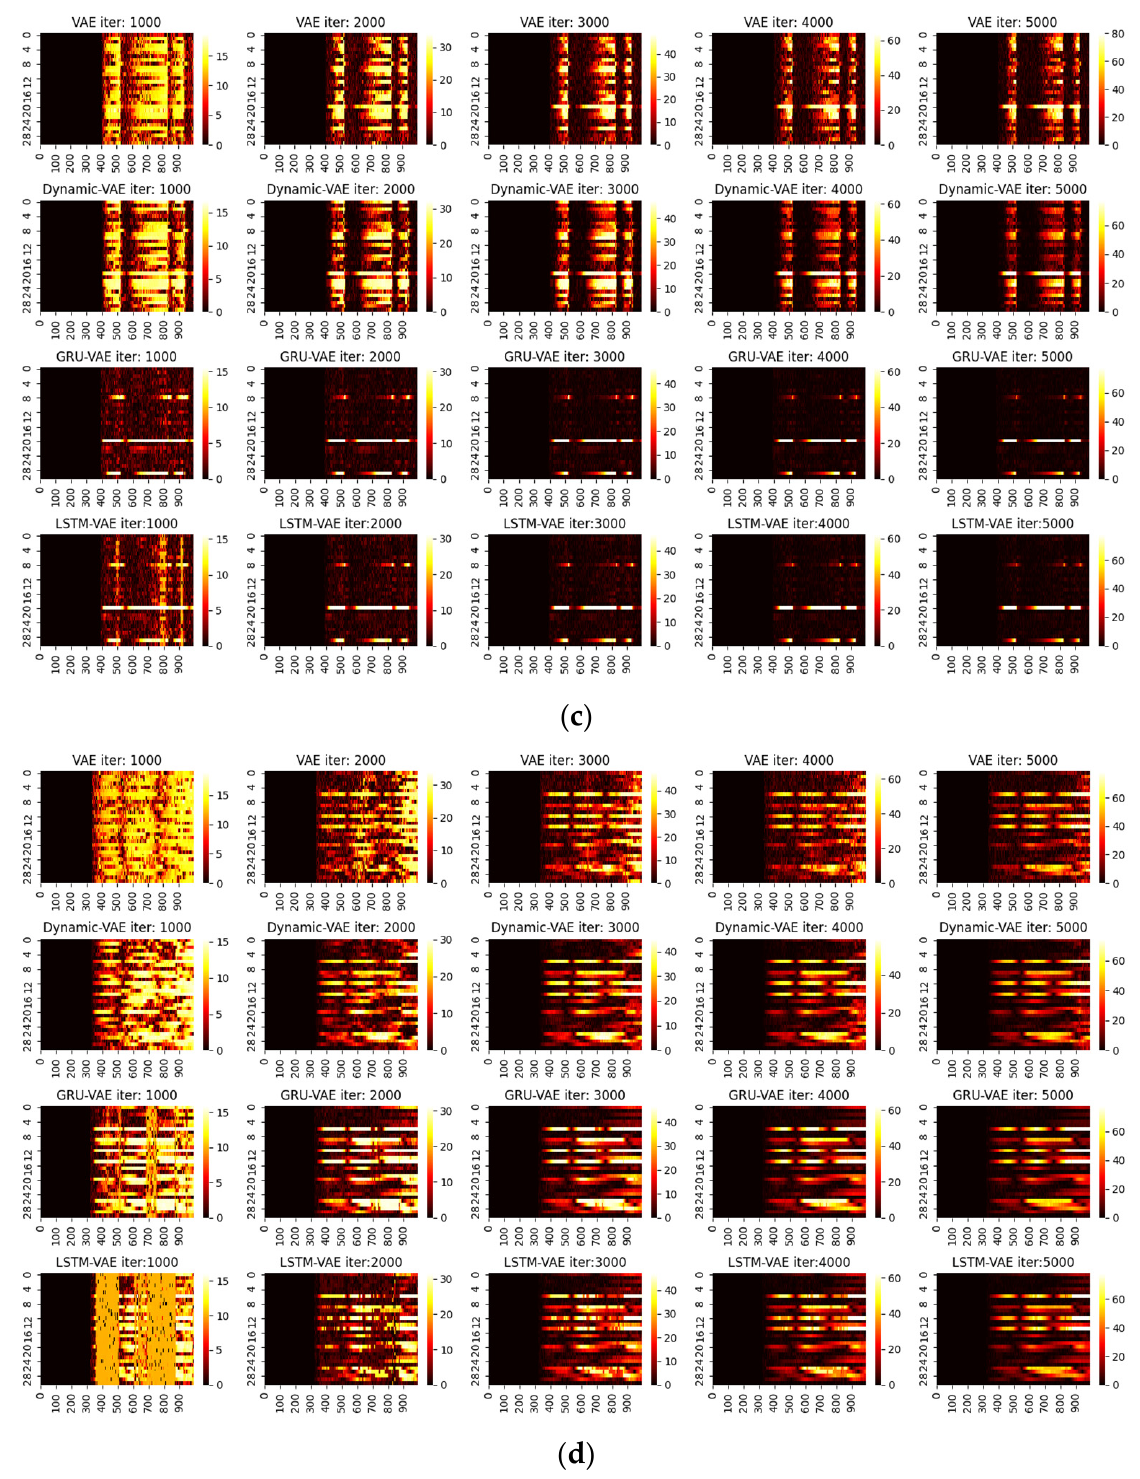
Figure 10. RBC contribution plot of VAE, Dynamic-VAE, GRU-VAE, and LSTM-VAE, with respect to max epochs of 1000, 2000, 3000, 4000, and 5000: ( a ) Fault 4, ( b ) Fault 20, ( c ) Fault 17, ( d ) Fault 13. One can see that the RBC plots from the static VAE can be very noisy even after deep optimizations. By contrast, VAE variants with spatial-temporal compositions can perform much better; this can be especially verified for GRU-VAE. Apart from that, one should note that the estimated fault magnitude can match the fault well in around 3000 steps for small faults such as 4 and 20. Using fault 20 as an example, the entire loss